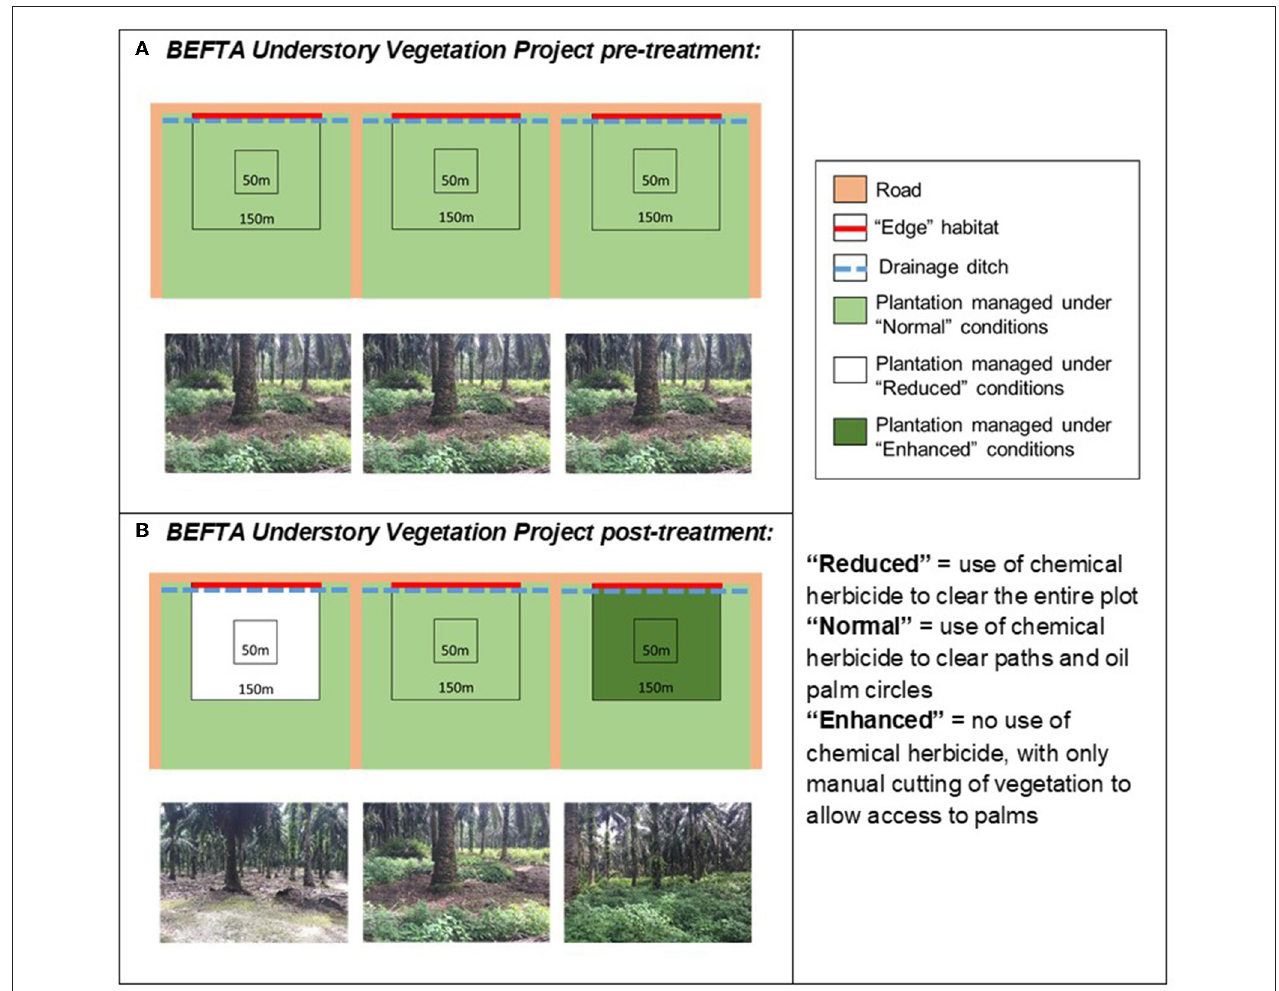
FIGURE 3 | Schematic to show the design of the BEFTA Understory Vegetation Project. Each diagram represents a set of three experimental plots, each of which is 150 × 150m, within which there is a central 50 × 50m area (the Core area) where the majority of measurements take place. The roadside edge of the plot is shown as a red line and is referred to as Edge habitat. Each plot is located at the 300m wide end of a plantation block (300 × 1,000m; note that the plots and blocks are not drawn to the same scale). (A) Represents the habitat management that all plots received “pre-treatment,” whilst (B) shows how management was altered “post-treatment.” This triplet design is replicated six times across two estates (Kandista and Ujung Tanjung) within the SMARTRI landscape (see Figure 1 ). In each triplet the order in which Normal, Reduced, and Enhanced treatments were allocated was randomised. This figure is reproduced and adjusted, with permission, from Luke et al.